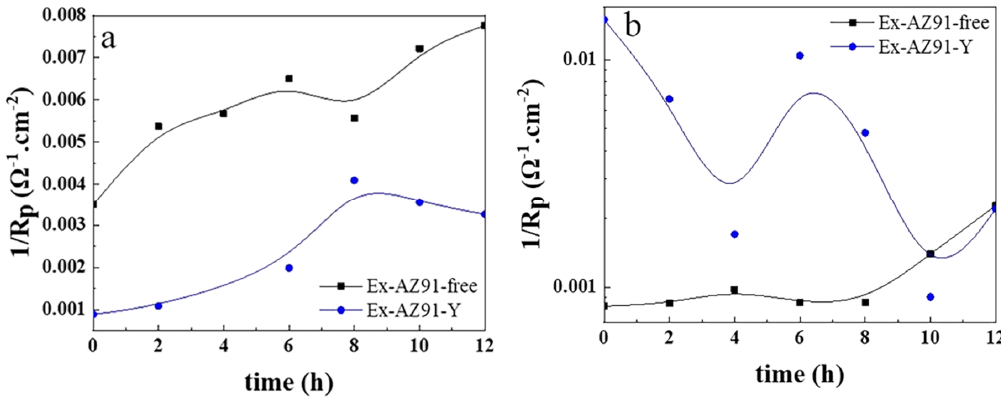
Figure 11. 1 / Rp of ( a ) transversal and ( b ) longitudinal section of Ex-AZ91-free and Ex-AZ91-Y alloy during various immersion times.